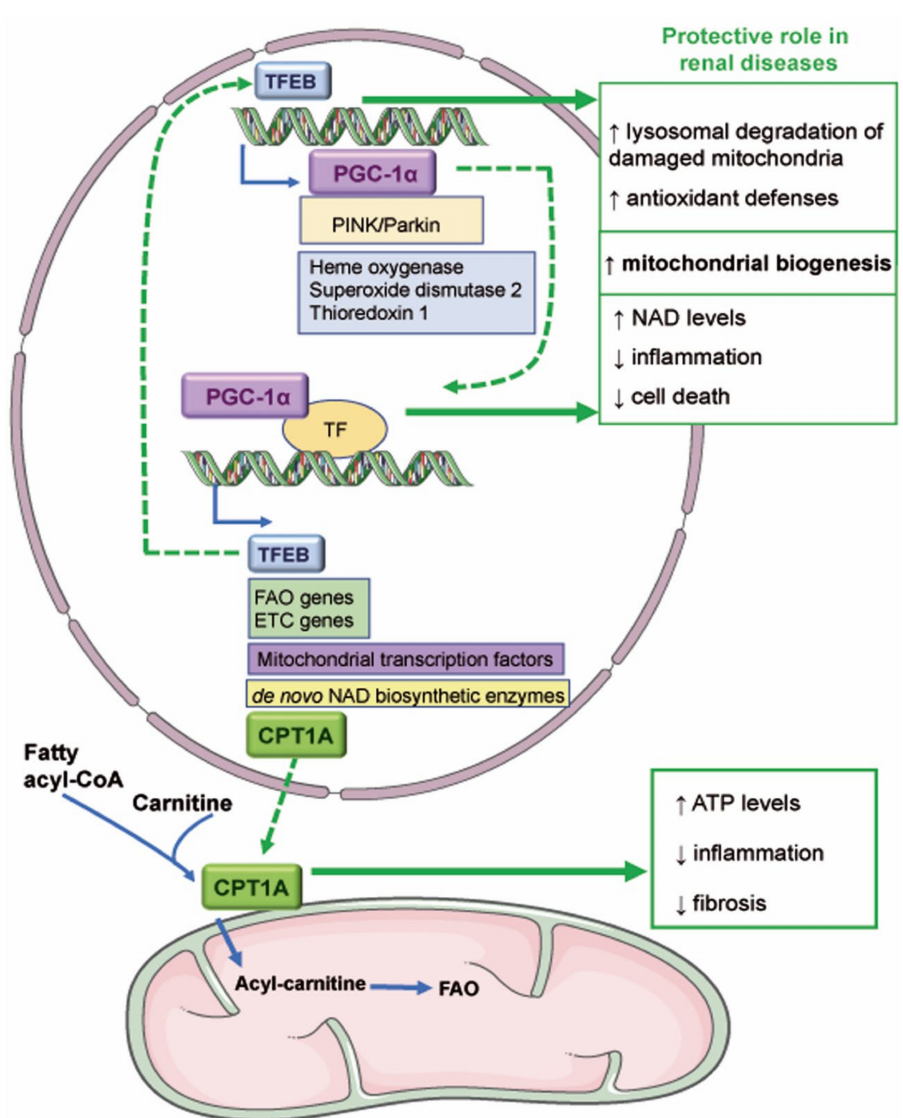
Figure 2. Novel mitochondria-related therapeutic targets in kidney disease. The transcriptional activity of TFEB promotes the expression of genes involved in mitochondrial biogenesis such as PGC-1 α and in antioxidant defenses. TFEB could be protective in AKI since it favors the degradation of damaged mitochondria and mitochondrial biogenesis. PGC-1 α regulates the expression of TFEB, fatty acid β -oxidation (FAO), and electron transport chain (ETC) genes, mitochondrial transcription factors, and de novo NAD biosynthetic enzymes. Various reports have demonstrated that PGC-1 α reduces renal inflammation and cell death and favors NAD synthesis and mitochondrial biogenesis. PGC-1 α may also mediate the expression of carnitine palmitoyl-transferase 1A (CPT1A),